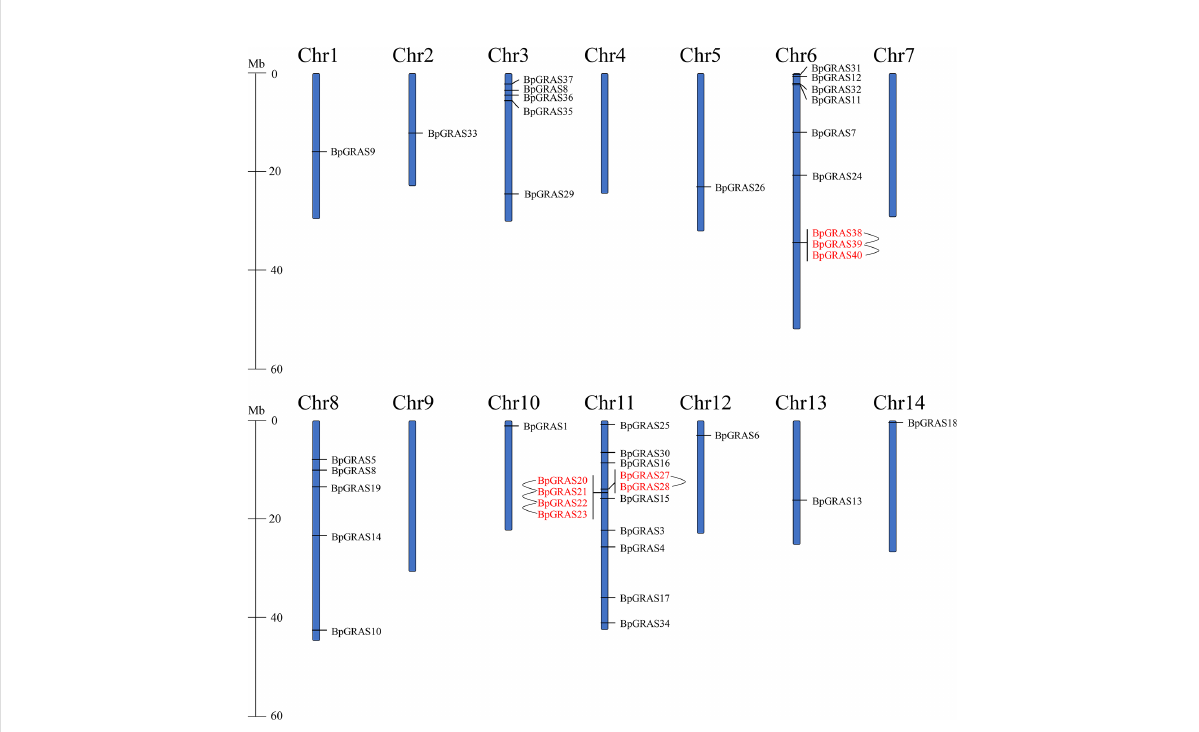
FIGURE 1 Positions and distributions of BpGRASs family members on 14 chromosomes of birch. Vertical bars represent the chromosomes of birch and the chromosome number is indicated beside each chromosome. Tandem duplicated genes are emphasized with red color and connected with black lines. The scale on the left represents chromosome